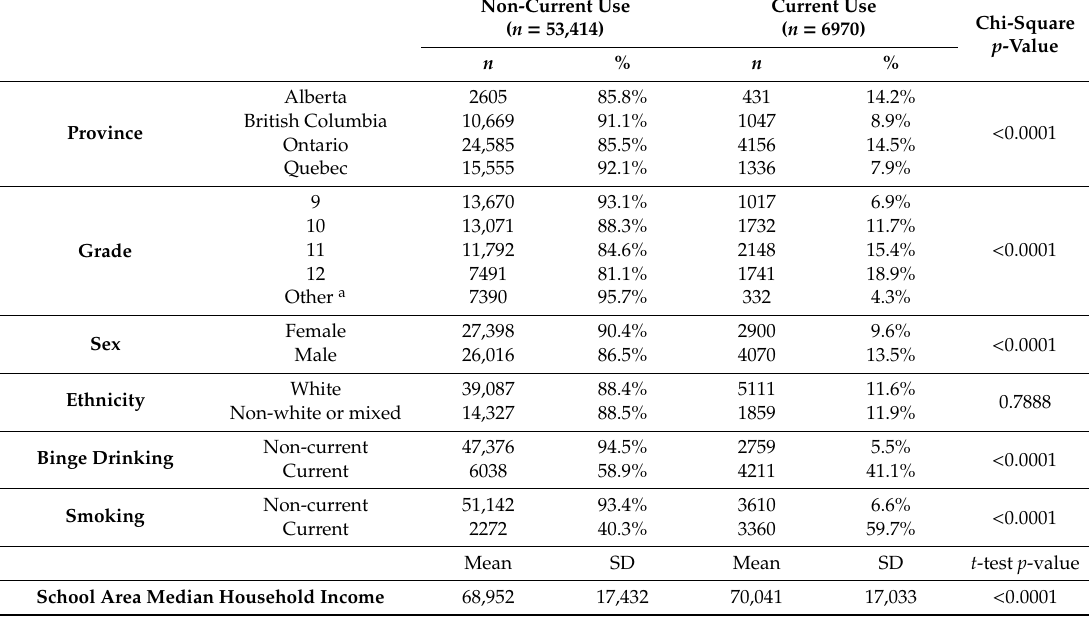
Descriptive statistics by student-reported cannabis use in Year 6 (2017 / 2018) of the COMPASS (Cannabis use, Obesity, Mental Health, Physical Activity, Alcohol use, Smoking, Sedentary behavior)